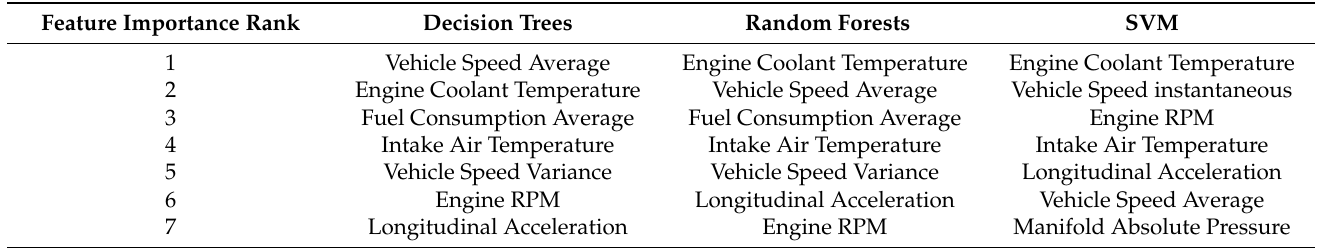
Table 7. Road traffic conditions feature importance using the permutation feature importance approach.